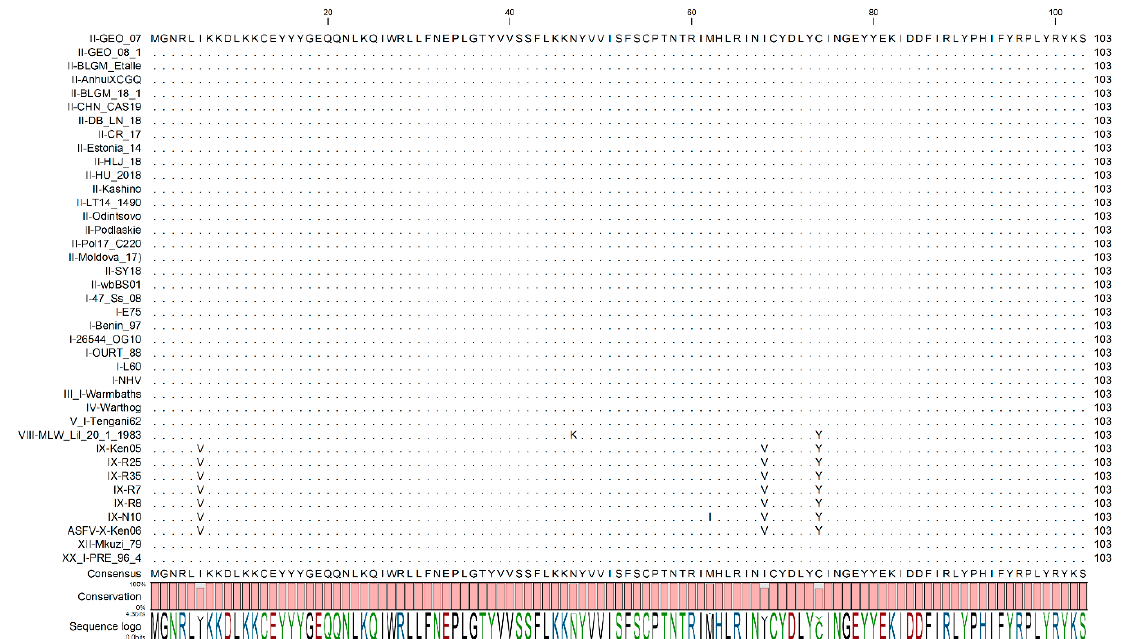
Figure 1. Multiple sequence alignment using CLC genomics workbench of I8L gene among the indicated African swine fever virus (ASFV) isolates for proteins. Matching residues are represented as dots. The degree of conservation is presented below the protein sequence and the conserved residue is presented on the bottom, indicating the degree of conservation for specific amino acid residues in the protein sequence.